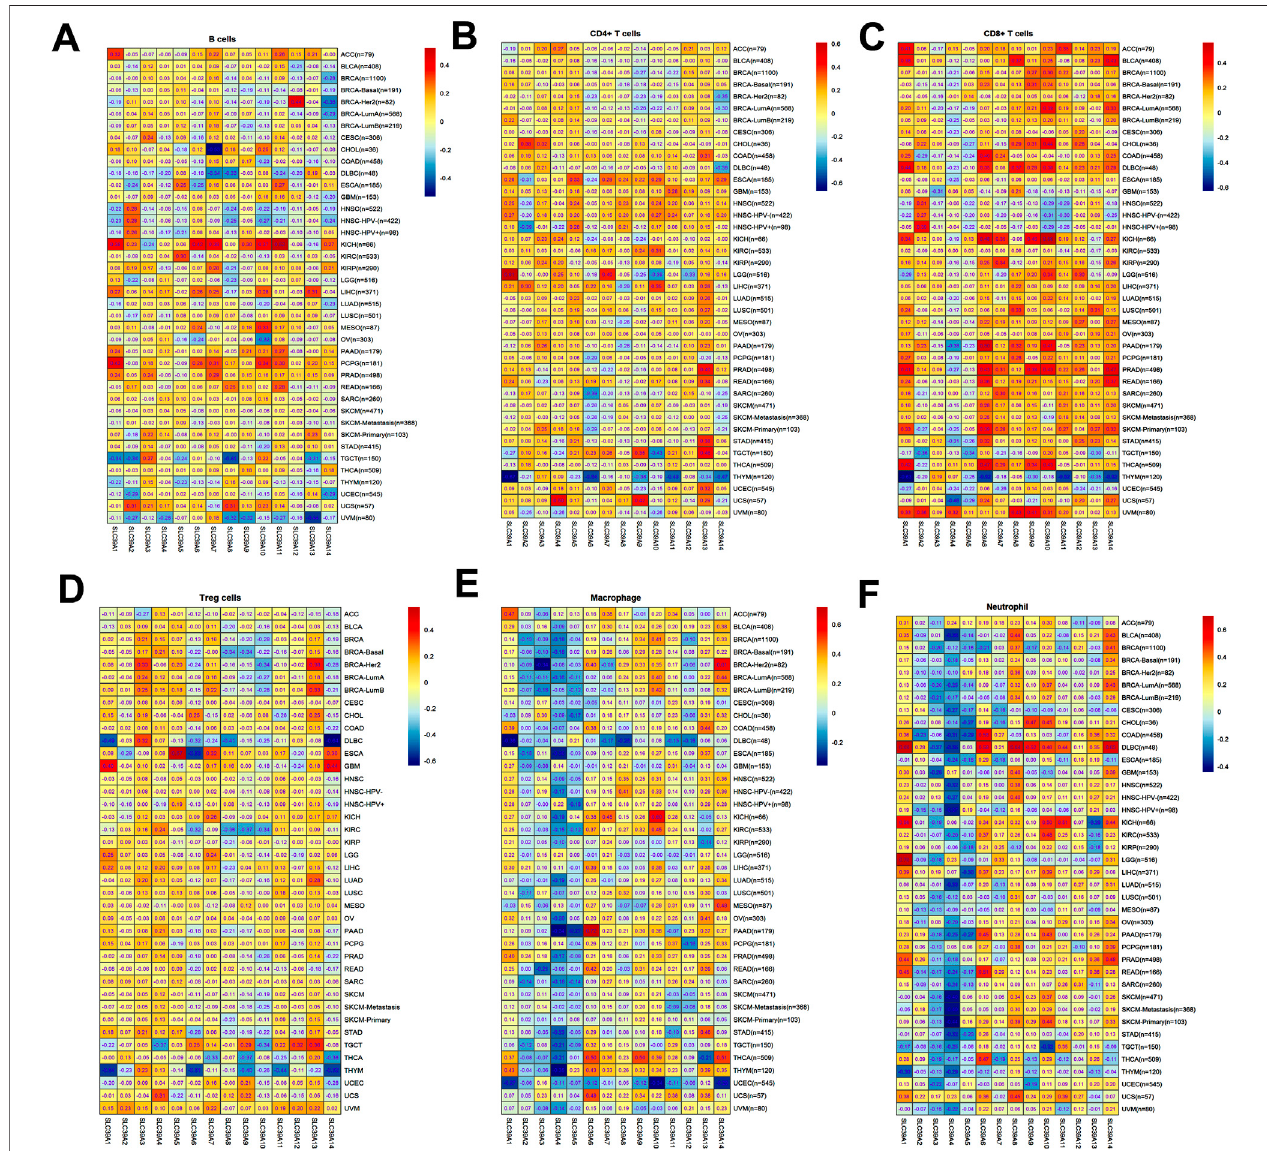
FIGURE 7 | Immune cell in fi ltration of the SLC39A family genes in pan-cancer derived from the TIMER2.0 dataset. (A) Correlation coef fi cient between SLC39A familygeneexpressionandB-cellin fi ltrationscoreinpan-cancer. (B) Correlationcoef fi cientbetween SLC39A familygeneexpression andCD4 + T-cellin fi ltration scorein pan-cancer. (C) Correlation coef fi cient between SLC39A family gene expression and CD8 + T-cell in fi ltration score in pan-cancer. (D) Correlation coef fi cient between SLC39A family gene expression and Treg T-cell in fi ltration score in pan-cancer. (E) Correlation coef fi cient between SLC39A family gene expression and macrophage cell in fi ltration score in pan-cancer. (F) Correlation coef fi cient between SLC39A family gene expression and neutrophil cell in fi ltration score in pan-cancer. The association was generated with tumor puri fi cation adjusted.